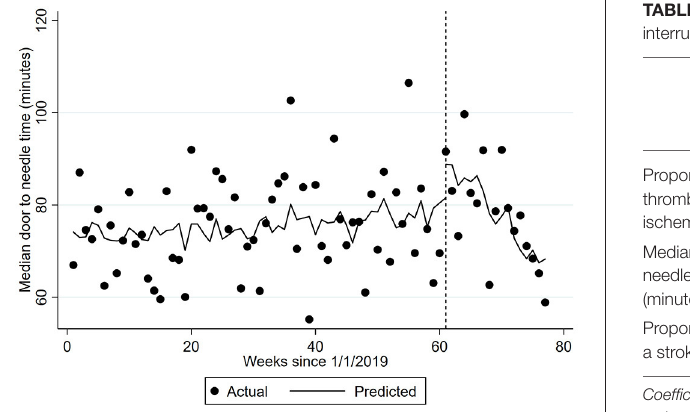
FIGURE 2 | Median door-to-needle time. The dots represent the median door-to-needle per week. The predicted time is adjusted for the number of patients with ischemic stroke and the corresponding number from the previous year (seasonality). Vertical hatched line represents week 61 of the interrupted time-series model with trends compared before and after this date, which coincides with the first COVID-19 related death. Coefficient − 2.0476 (95% CI − 2.36, − 1.73) p < 0.0001.